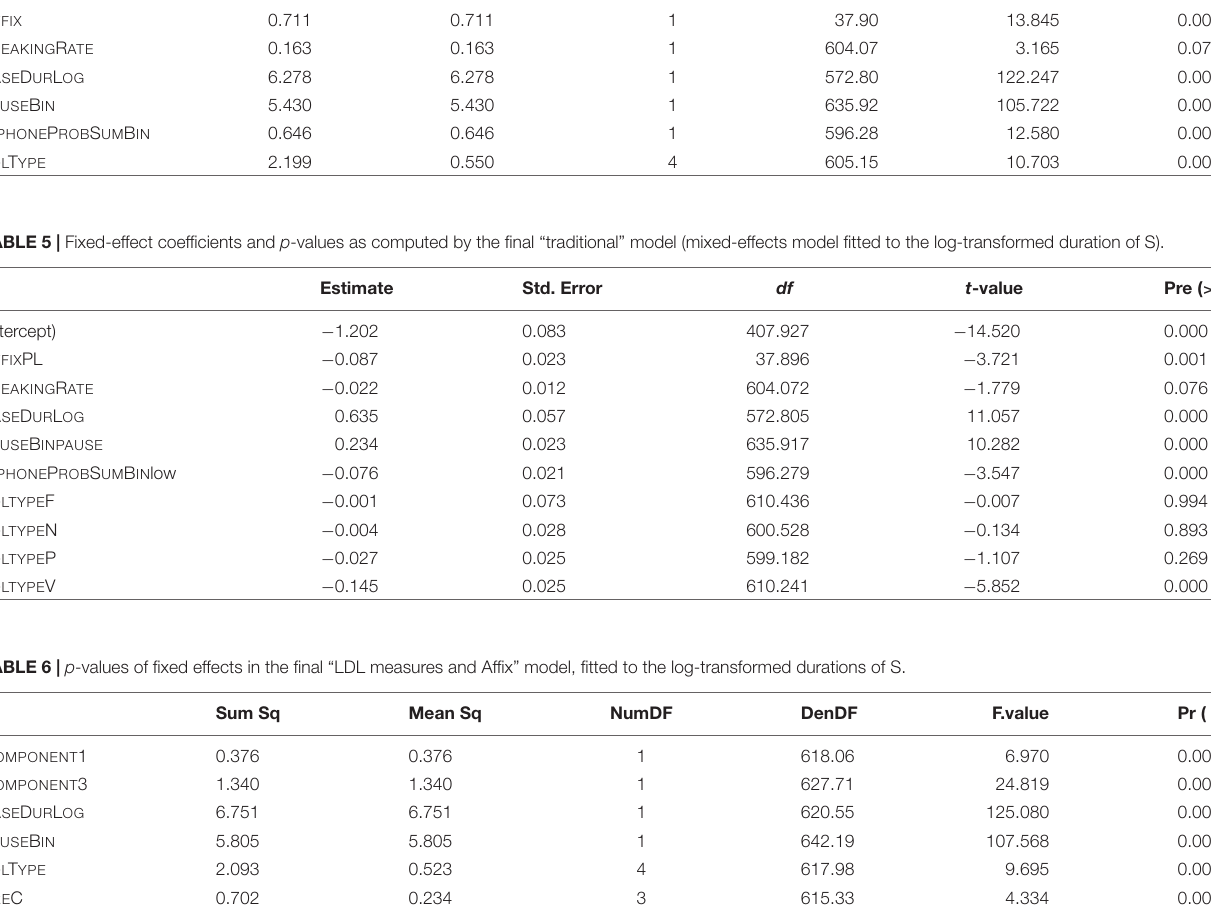
TABLE 4 | p -values of fixed effects in the final “traditional” model, fitted to the log-transformed durations of S. Sum Sq Mean Sq NumDF DenDF F.value